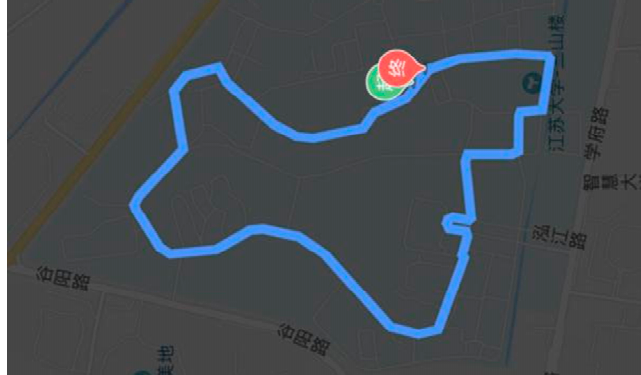
Figure 4. The designed test routes.